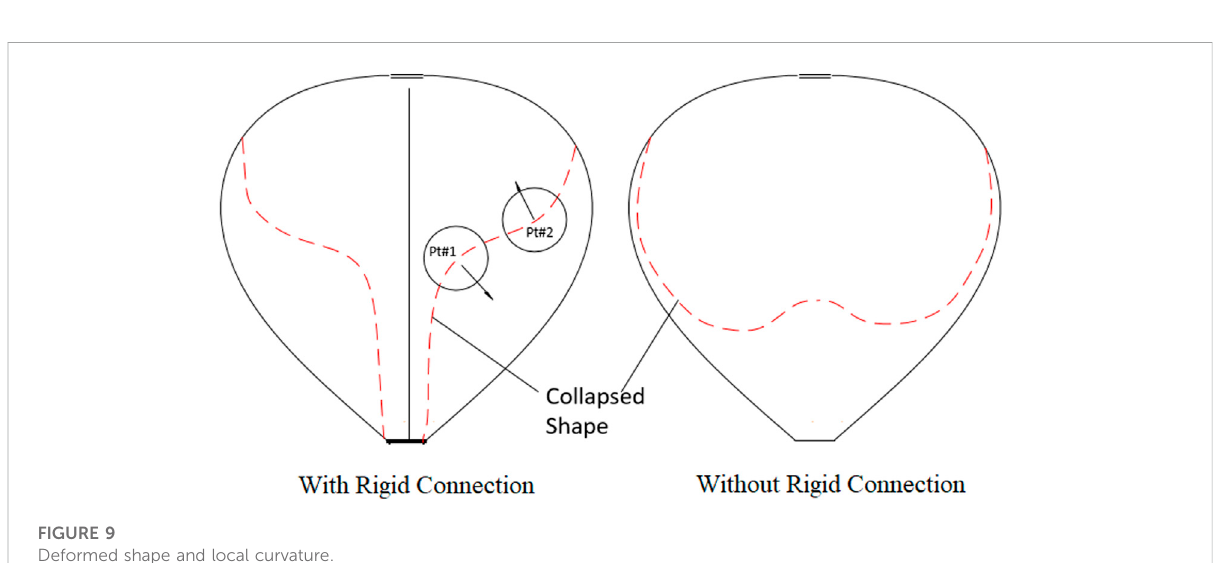
FIGURE 9 Deformed shape and local